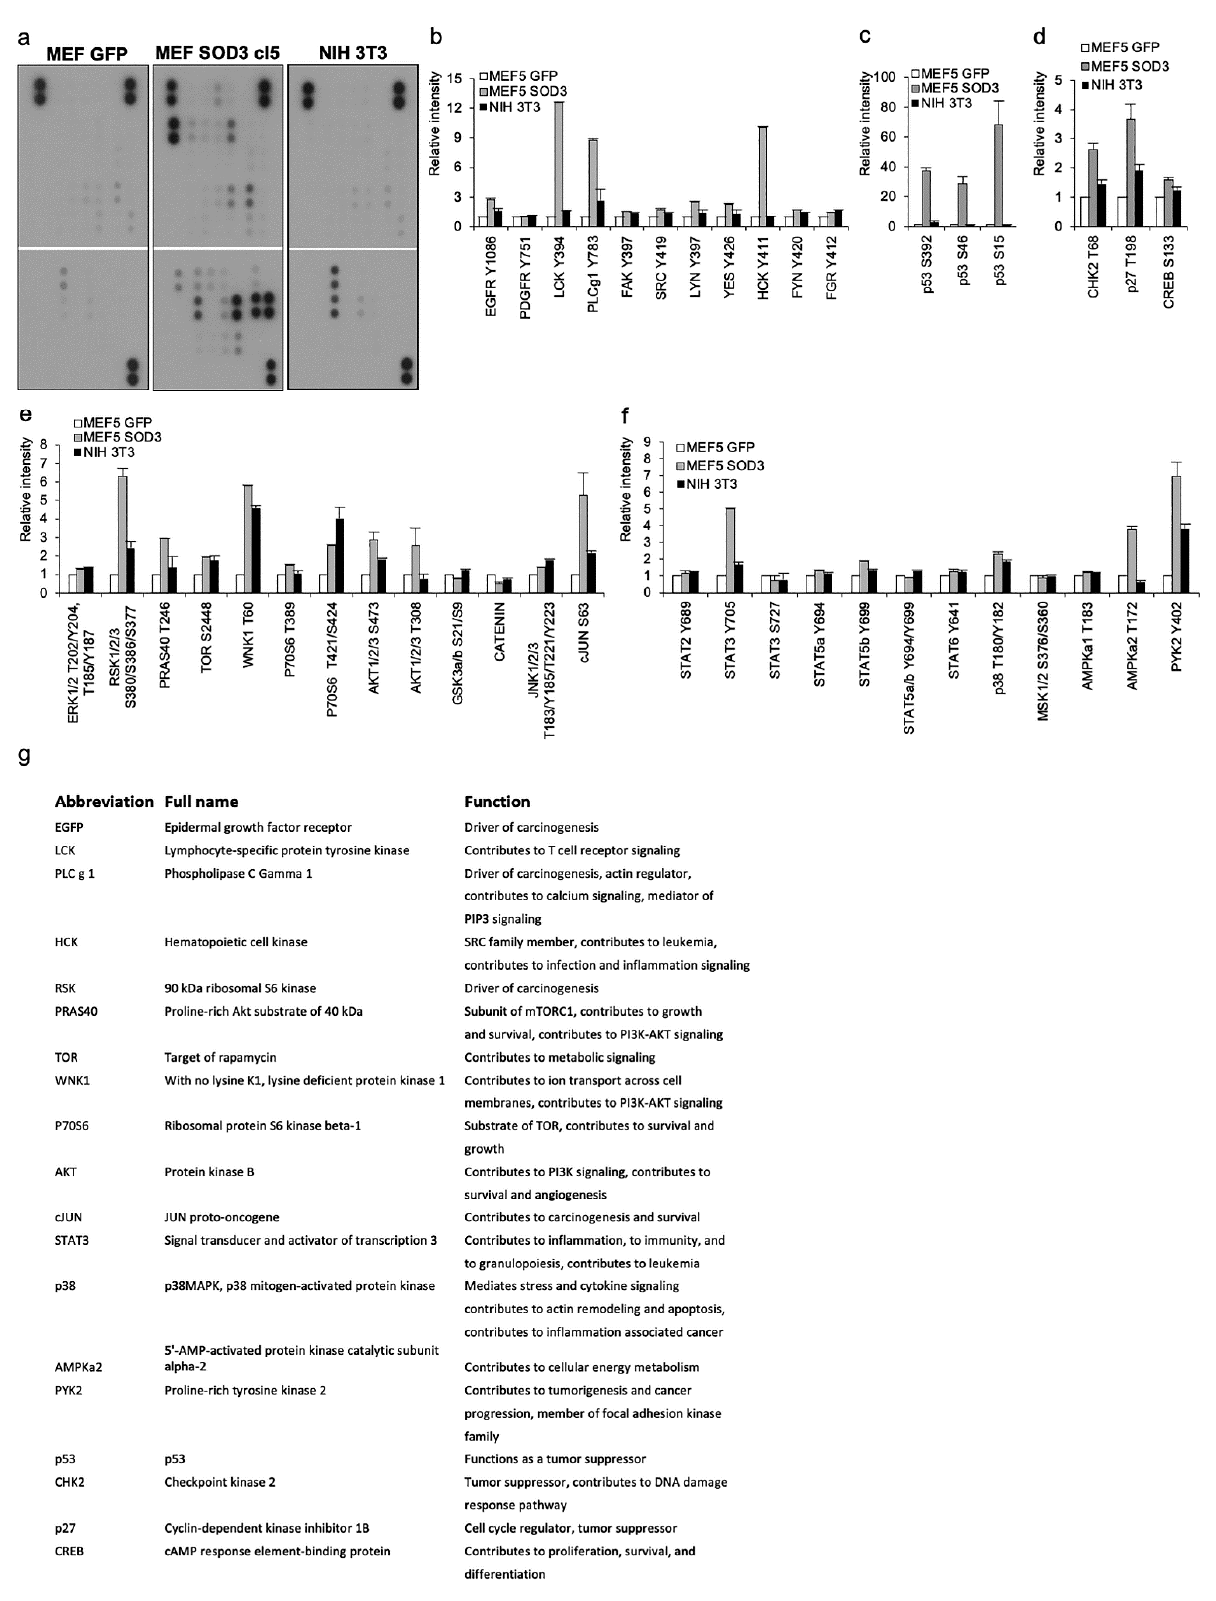
Figure 4. Kinase activation analysis. ( a ) The comparison of MEF GFP, MEF SOD3, and NIH3T3 demonstrated marked differences in the signaling pathways, inducing immortalization by sod3 and SV40 . ( b – f ) Groups of cell membrane- associated signaling molecules activated by SOD3. ( g ) Table showing the function of the selected signaling molecules with robust